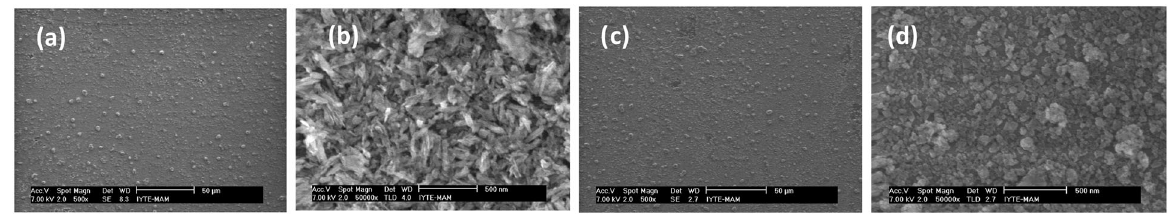
Fig. 1 The SEM images of the c-HAp coatings on the glass substrates prepared by 15w% solid content sol by dip coating, at various mag- ni fi cations ( a ) 500x, ( b ) 50,000x, and the m-HAp coatings on the